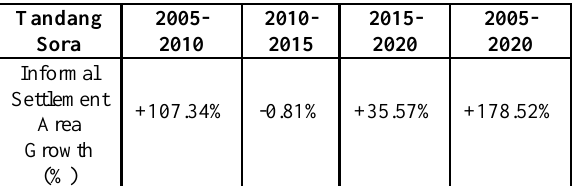
Table 8. Informal Settlement Growth in Percentage in Brgy. Tandang